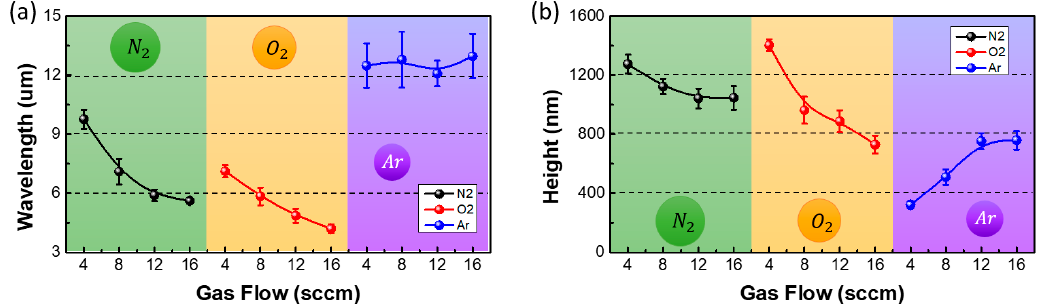
Figure 7. Variation in the ( a ) wavelengths and ( b ) heights of the wrinkles with the gas flow rates during nitrogen, oxygen, and argon plasma treatments.